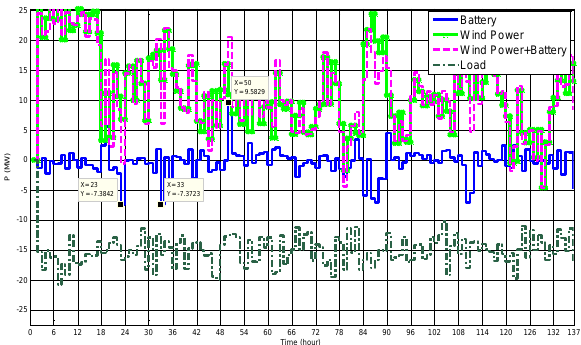
Fig.11 . Curves of active power (measurement at the battery has an error in snapshots 23, 35,